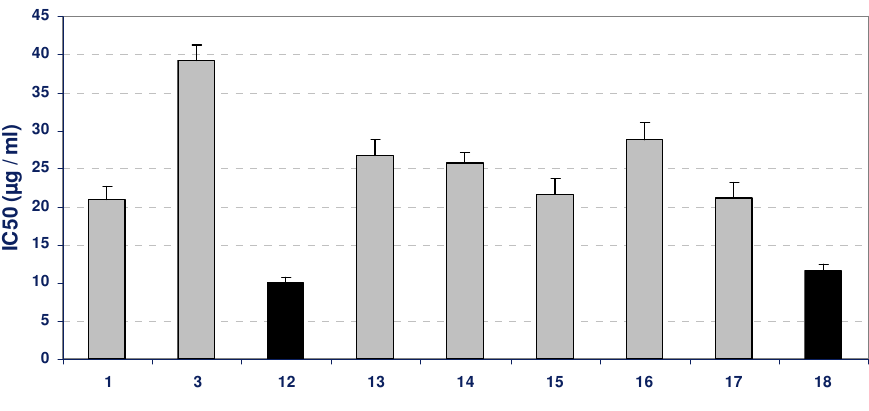
Figure 2. Cytotoxicity (IC50, µg/mL) of different tested compounds against human MCF-7 cells 48 hours of incubation. The grey bars represent non-cytotoxic compounds, and the black bars represent the promising cytotoxic compounds. Data represent mean ± value of IC 50